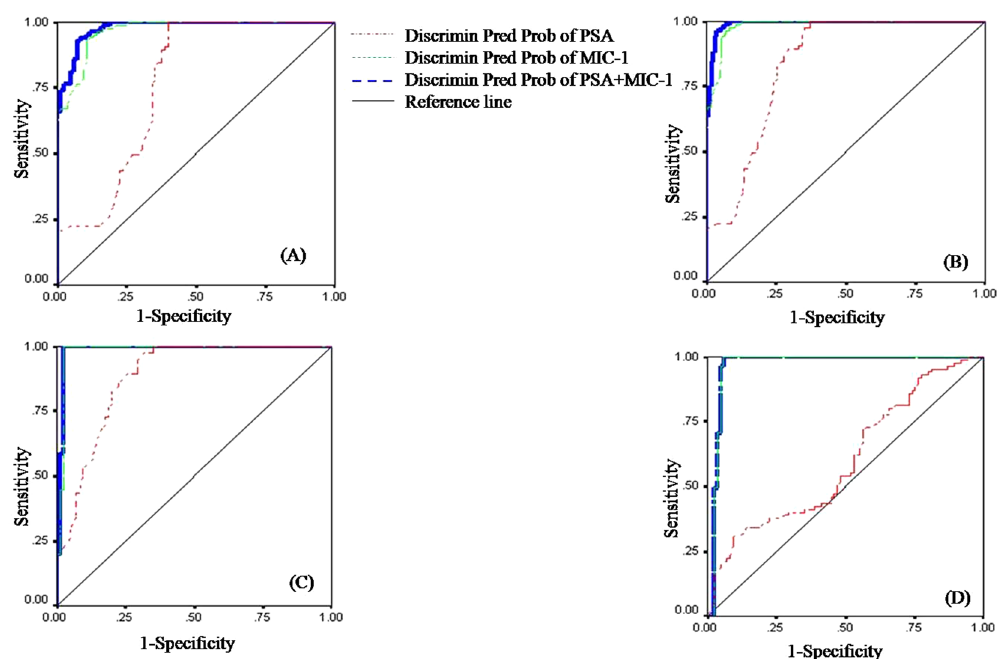
Figure 4. Appraisal of AUC of ROC depicting the diagnostic accuracy based on discriminant predicted probability of PSA, MIC-1, and combination of both these protein biomarkers. AUC of ROC curves of ( A ) HC vs. BPH + PC, ( B ) HC vs. BPH, ( C ) HC vs. PC, and ( D ) BPH vs. PC, details shown in Table 2. Here, HC: healthy control; BPH: benign prostate hyperplasia; PC: prostate